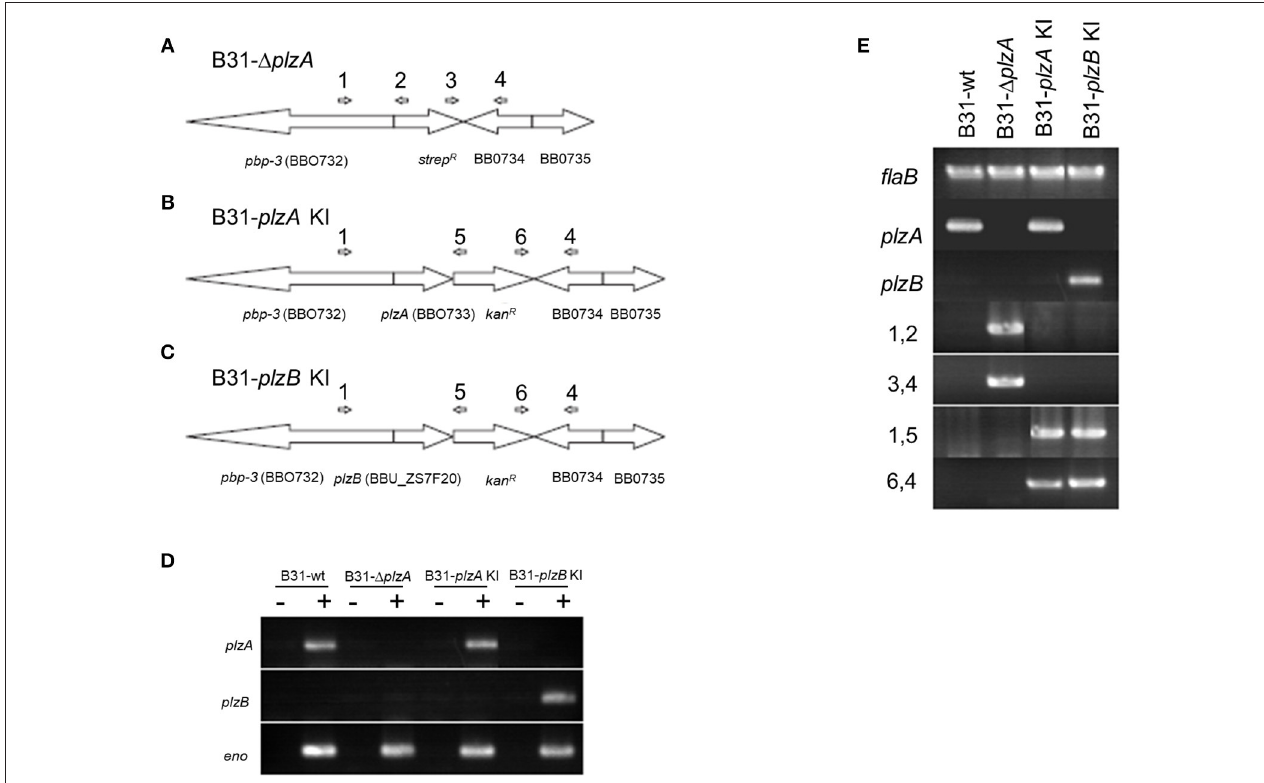
FIGURE 2 | Generation and confirmation of genetic constructs. (A) Depicts in schematic form the organization of the plzA locus of the B. burgdorferi B31 linear chromosome after replacement of plzA with a strep R cassette. (B,C) Depict the gene organization of the same region of the chromosome after cis- complementation or “knock in” (KI) with plzA or plzB , respectively. Note that the intergenic regions between are not indicated in the schematics. The ORF designations originally assigned to the B. burgdorferi B31 genome are indicated. The general location of hybridization sites for primers used to verify the intended allelic exchange events are indicated above each schematic with the PCR results presented in (E) . Amplification of the flaB gene served as a positive control for PCR. (D) Shows the results of RT-PCR analyses conducted to assess transcription of each gene. Amplification of the enolase gene served as a positive control for RT-PCR. The plus and minus signs indicate the inclusion or absence of reverse transcriptase in the reactions. All primers used in this study are listed in Table 1 . Note that the PCR gel images are composites of images from independent gels that were cropped and aligned for reader convenience.